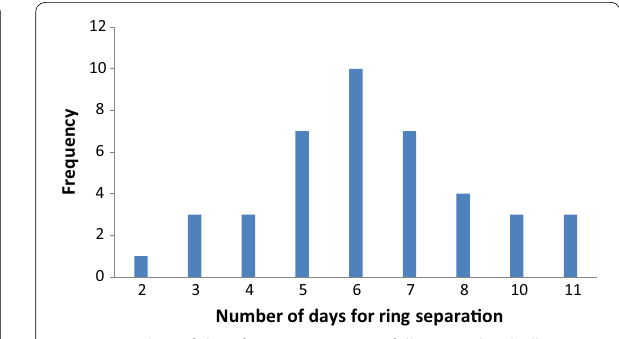
Fig. 4 Number of days for ring separation following Plastibell circumcision